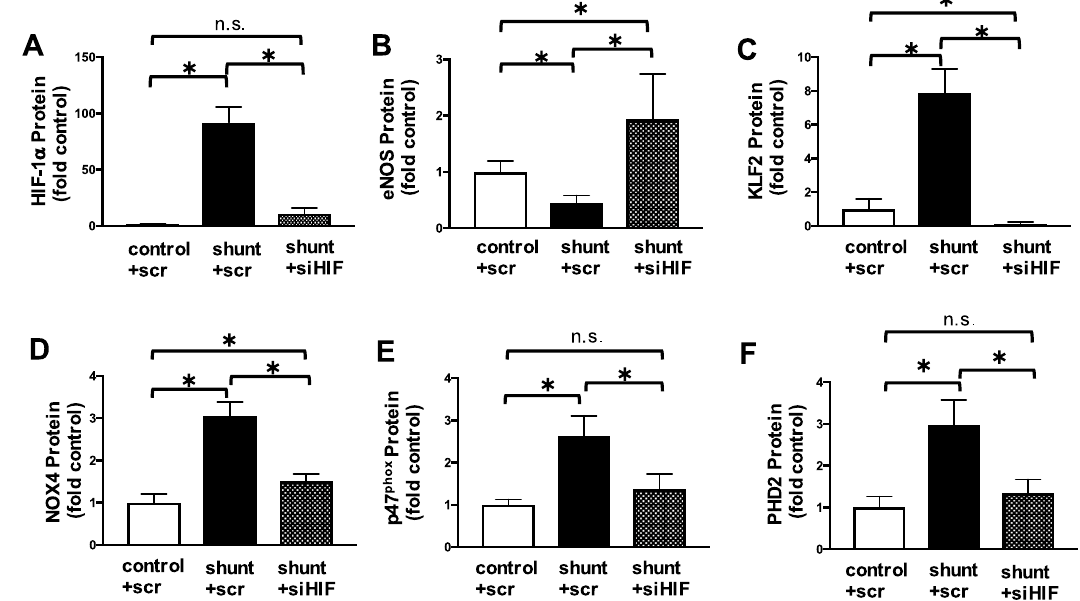
Figure 5. HIF-1α knockdown in shunt LECs. In all panels values are normalized to scramble treated control LECs. ( A ) Treatment with HIF-1α siRNA decreases detectable HIF-1α protein in shunt LECs from 92-fold to 11-fold scramble treated controls. ( B ) In scramble treated shunt LECs, eNOS protein is 0.45-fold scramble treated controls; treatment with HIF-1α siRNA increases eNOS protein in shunt LECs to 1.9-fold scramble treated controls. ( C ) Treatment with HIF-1α siRNA decreases KLF2 protein in shunt LECs from 7.9-fold to 0.14-fold scramble treated controls. ( D ) Treatment with HIF-1α siRNA decreases NOX4 protein in shunt LECs from 3.1-fold to 1.5-fold scramble treated controls, and ( E ) decreases p47 phox protein in shunt LECs from 2.6- fold to 1.4-fold scramble treated controls. ( F ) Scramble treated shunt LECs express threefold increased levels of the canonical HIF-1α target PHD2 compared to scramble treated controls, while treatment with HIF-1α siRNA decreases PHD2 protein in shunt LECs to 1.3-fold scramble treated controls. For each panel, *, P < 0.05; n = 5 control + scr, 5 shunt + scr, 5 shunt + siHIF-1α, and error bars represent standard